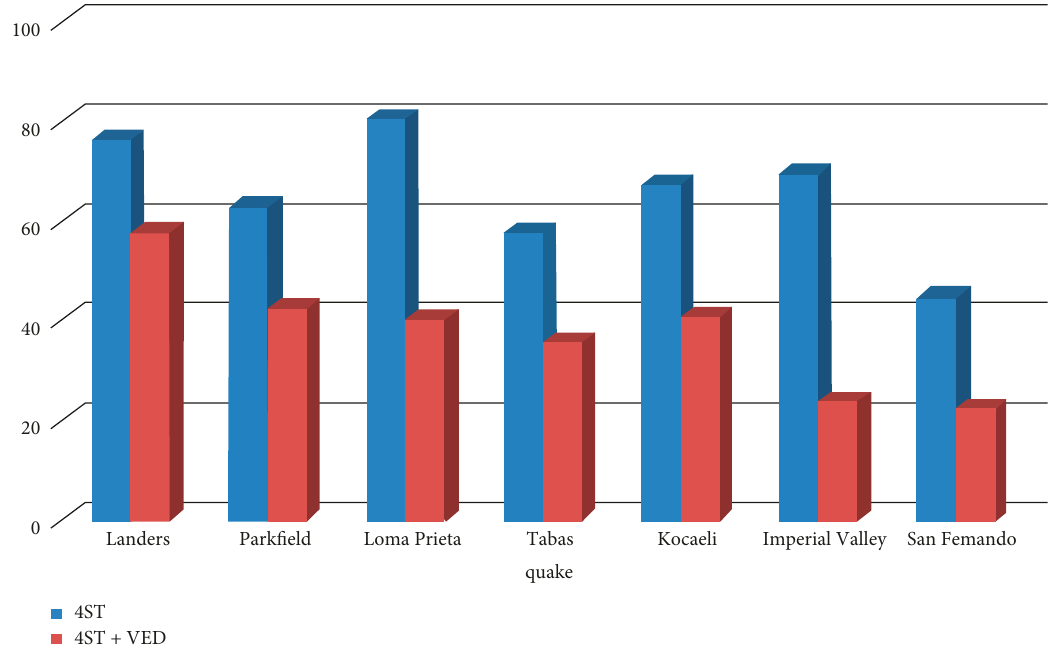
Figure 17: Shear base of a 12-story frame under near-field records in two modes with and without dampers